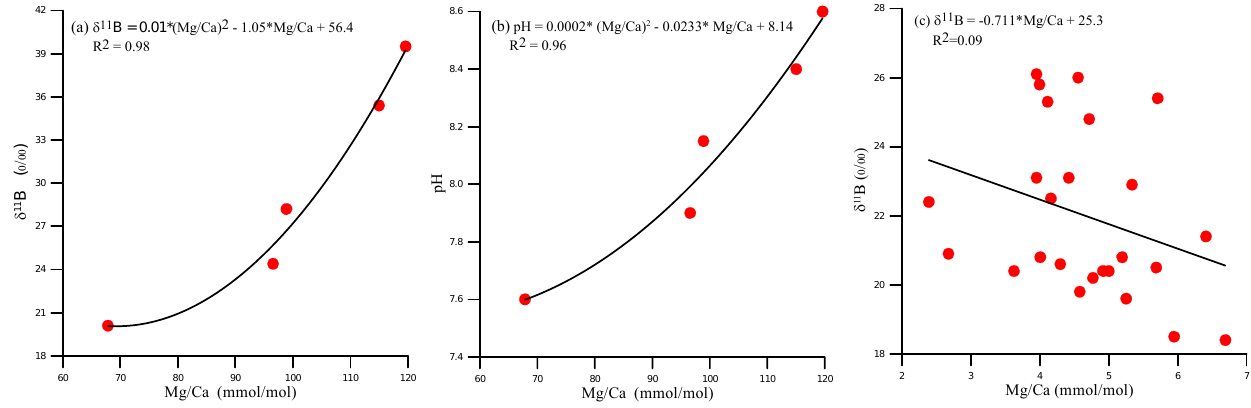
Fig. 9. Relationship (a) between Mg/Ca and δ 11 B in inorganic calcite, (b) between Mg/Ca and seawater pH (Xiao et al., 2006a), and (c) between Mg/Ca and δ 11 B in corals in Sanya Bay (Xiao et al., 2006b). The Mg/Ca was positive with δ 11 B in inorganic calcite and increased with seawater pH.